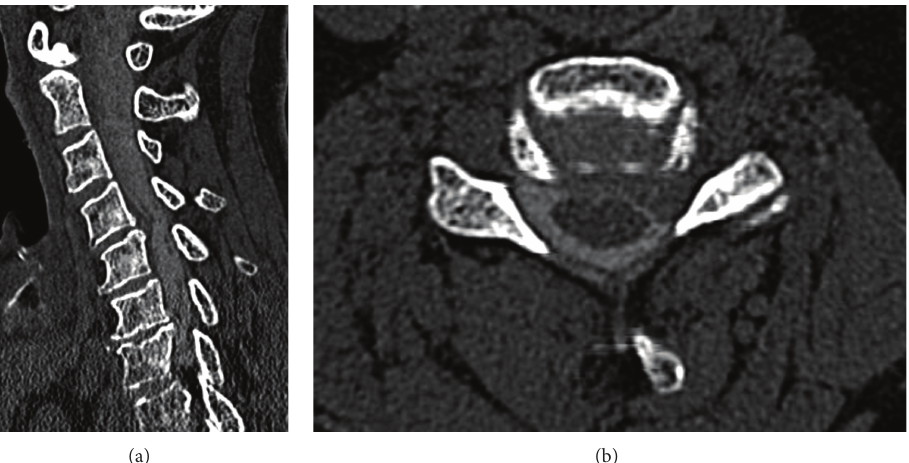
Figure 1: Computed tomography after myelography showing left-side C4-5 disc herniation. (a) Parasagittal view and (b) axial view at the C4-5 level.